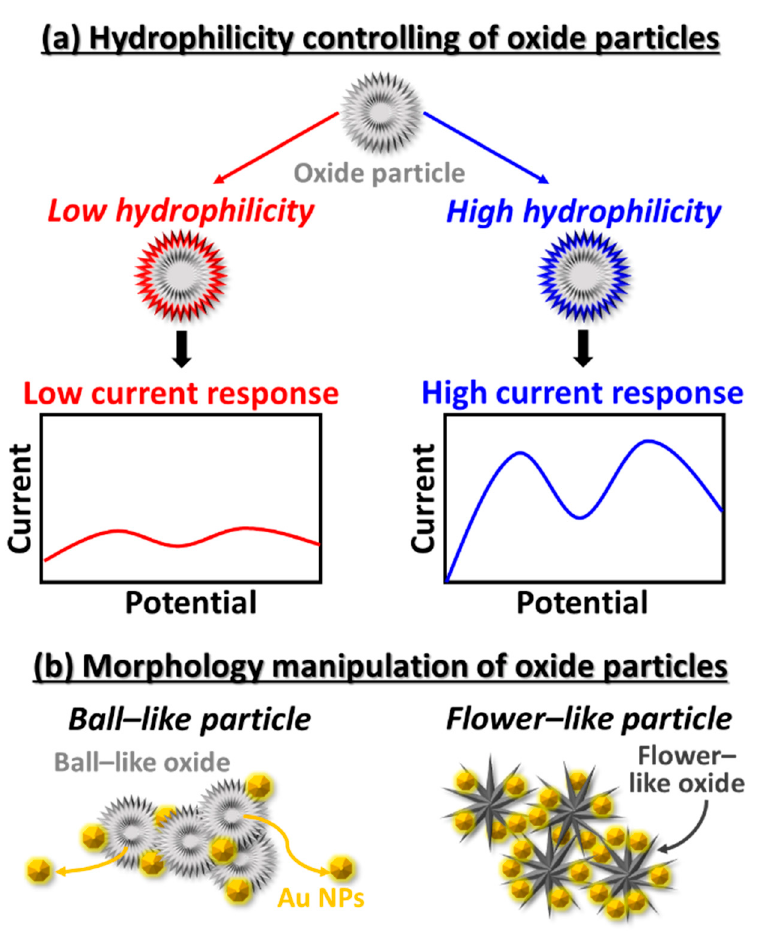
Figure 16. ( a ) Combination of the ball-like oxide and the Au NPs. ( b ) Integration of the flower-like oxide and the Au NPs. (The yellow arrows indicate the loss of the Au NPs from the oxide to the environment.).